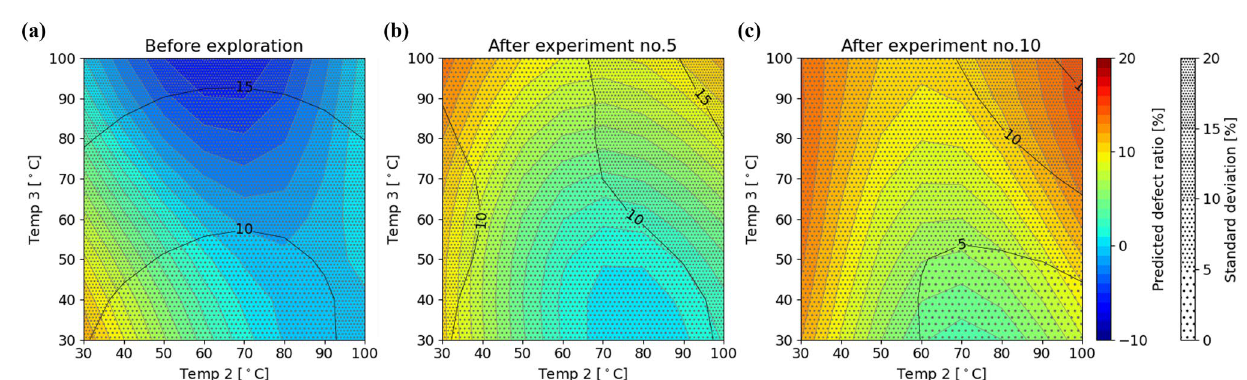
Figure 3. Prediction maps of the relationship between the temperature profiles during drying and defect ratios ( a ) before exploration, ( b ) after five experiments, and ( c ) after ten experiments of exploration. To visualize this, the second and third temperature profiles have been extracted and shown. Moreover, the uncertainty σ is shown by hatching. Since the prediction range of the defect ratio was not restricted, negative defect ratios are seen